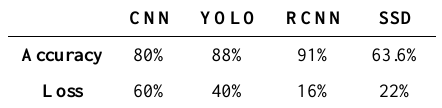
Figure 19. Comparison of CNN vs. YOLO vs. Faster RCNN Table 1. Comparison of performance of CNN vs. YOLO vs. Faster